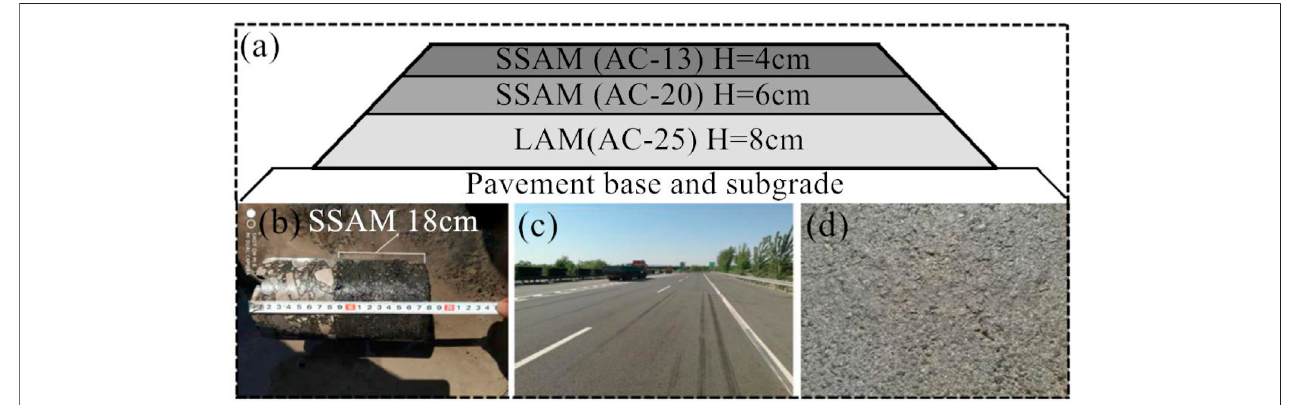
FIGURE9| Testroad: (A) schematicdiagramofamainlinepavementstructure; (B) coredrillingsample; (C) conditionofthetestsection;and (D) surfaceofthetest section.